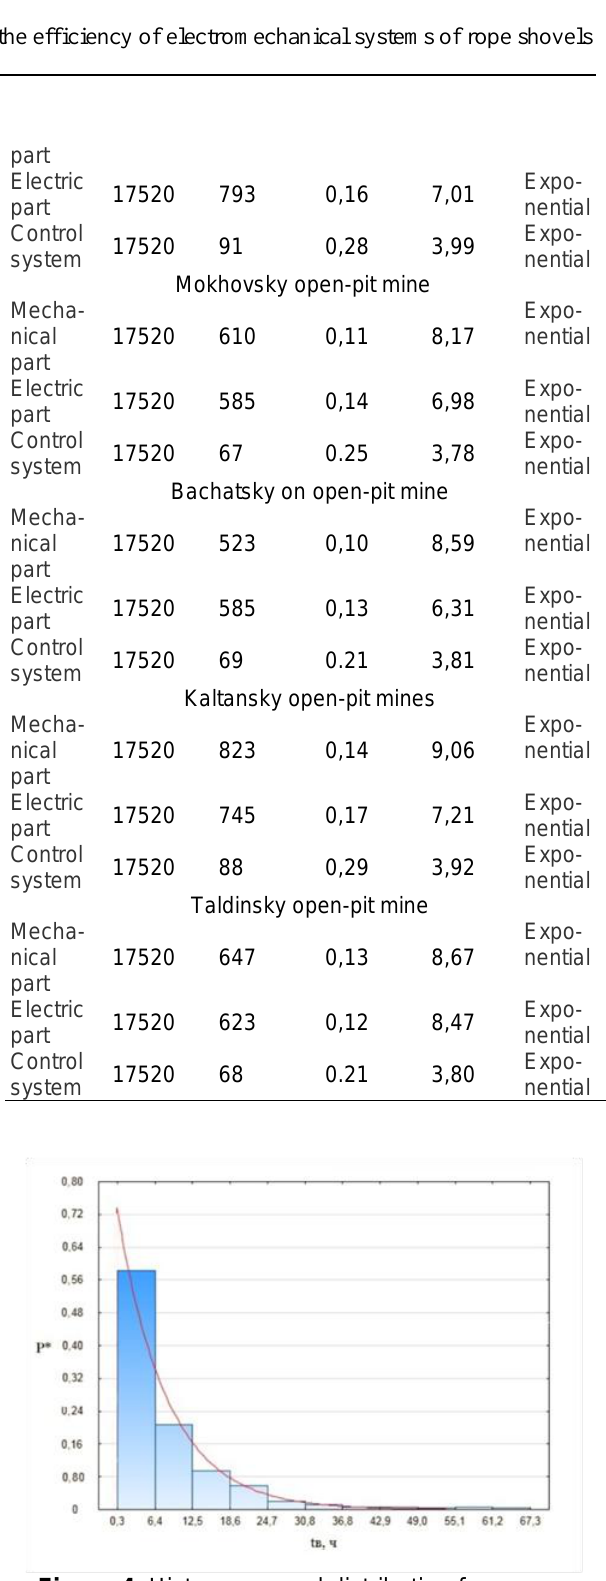
Figure 4. Histograms and distribution frequency functions of restoring time of a mechanical part of rope